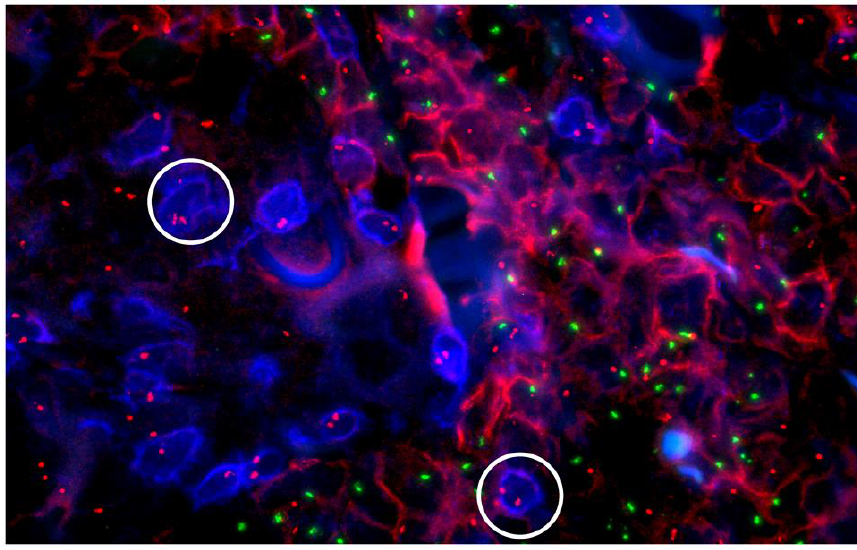
Figure 2. An example of multiprobe imaging. A male patient with myeloid leukaemia was transplanted with his sister’s bone mar- row. He subsequently relapsed and was diagnosed with a cutaneous T-cell lymphoma. The origin of this lymphoma was investigated using FISH and immunostaining. None of the CD3+, T-lymphoma cells (blue, e.g., circled) have a Y chromosome (green spots); the CD54+, myeloid cells (red) have X (red spots) and Y chromosomes. Conclusion: The T-cell lymphoma a rose from the sister’s marrow .